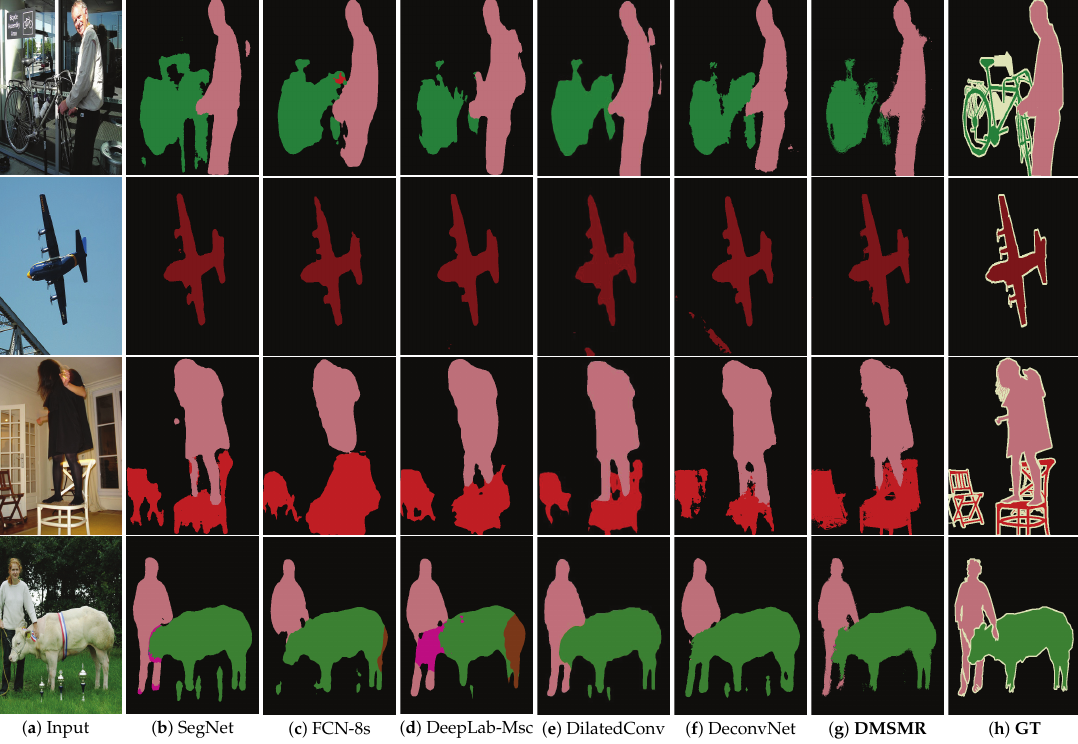
Figure 3. Several semantic segmentation results on PASCAL VOC 2012 validation images. DMSMR : Semantic segmentation result predicted by dual multi-scale manifold ranking network. GT : Ground